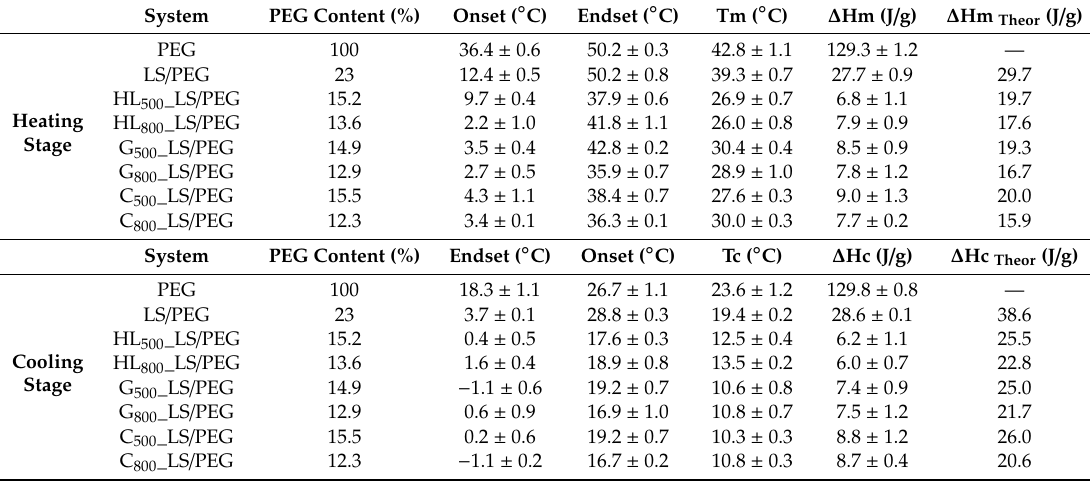
Table 3. Characteristic (initial, end and peak) temperatures and enthalpy measured during heating stage (melting) and subsequent cooling stage (crystallization) on pure PEG, on LS / PEG composite and on mortars, based on di ff erent binders, containing LS / PEG composite. For each investigated system, the content in PEG as a percentage and the theoretical enthalpies (as defined in Equation (1)), for both melting ( ∆ Hm Theor ) and crystallization ( ∆ Hc Theor ), are